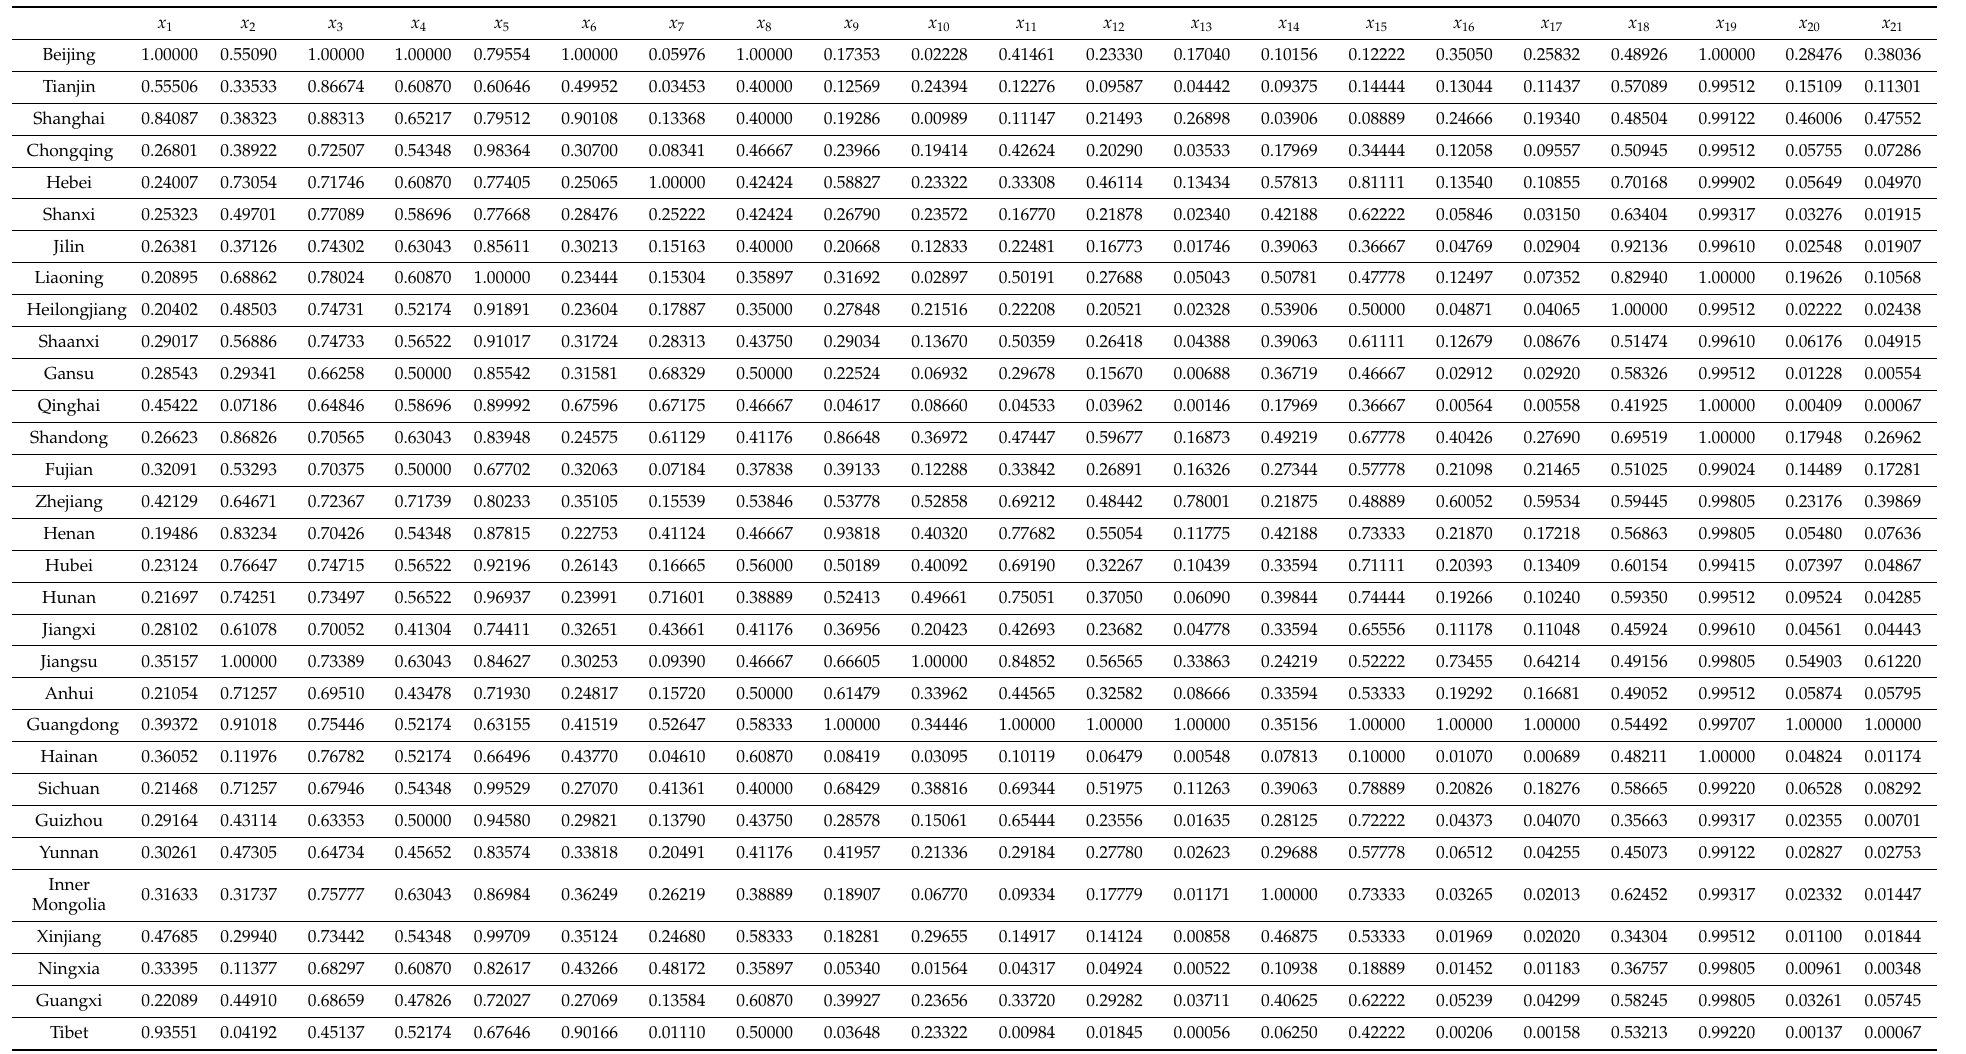
Table A8. The normalized decision